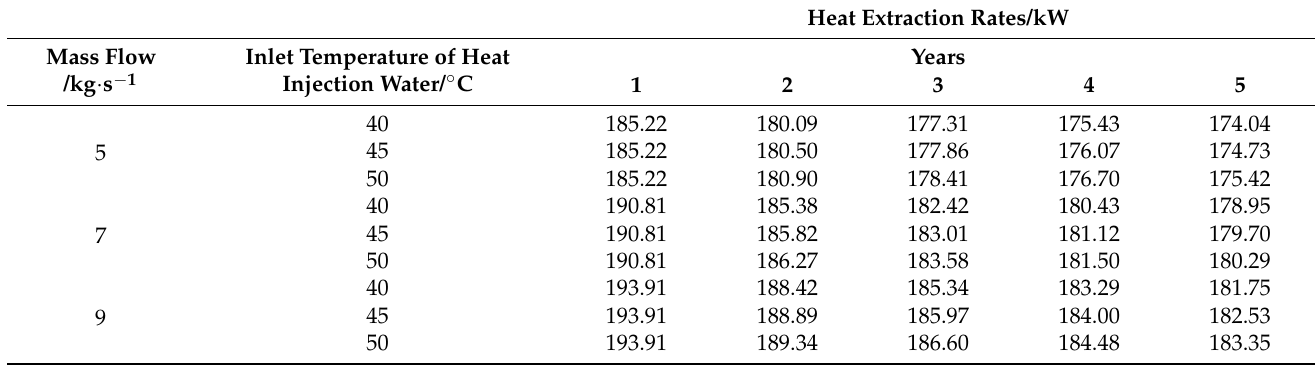
Table 7. Heat extraction rates over five years with cooling in summer.